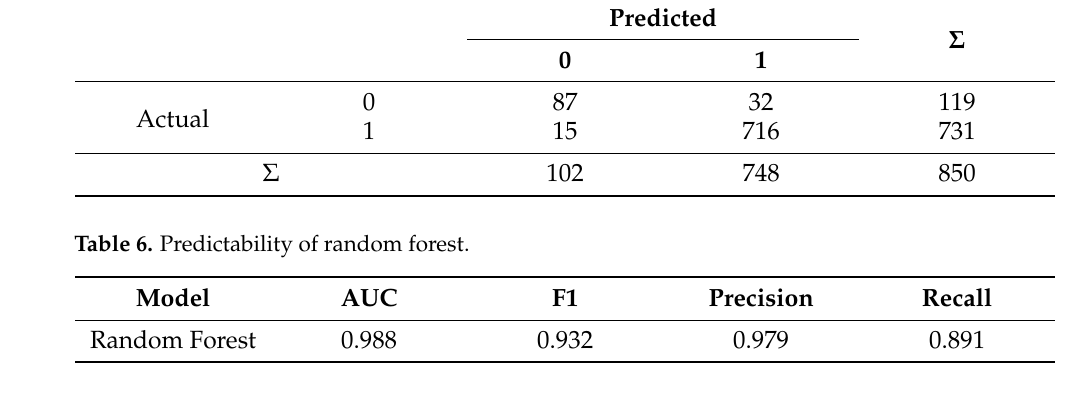
Table 5. Confusion matrix for random forest.